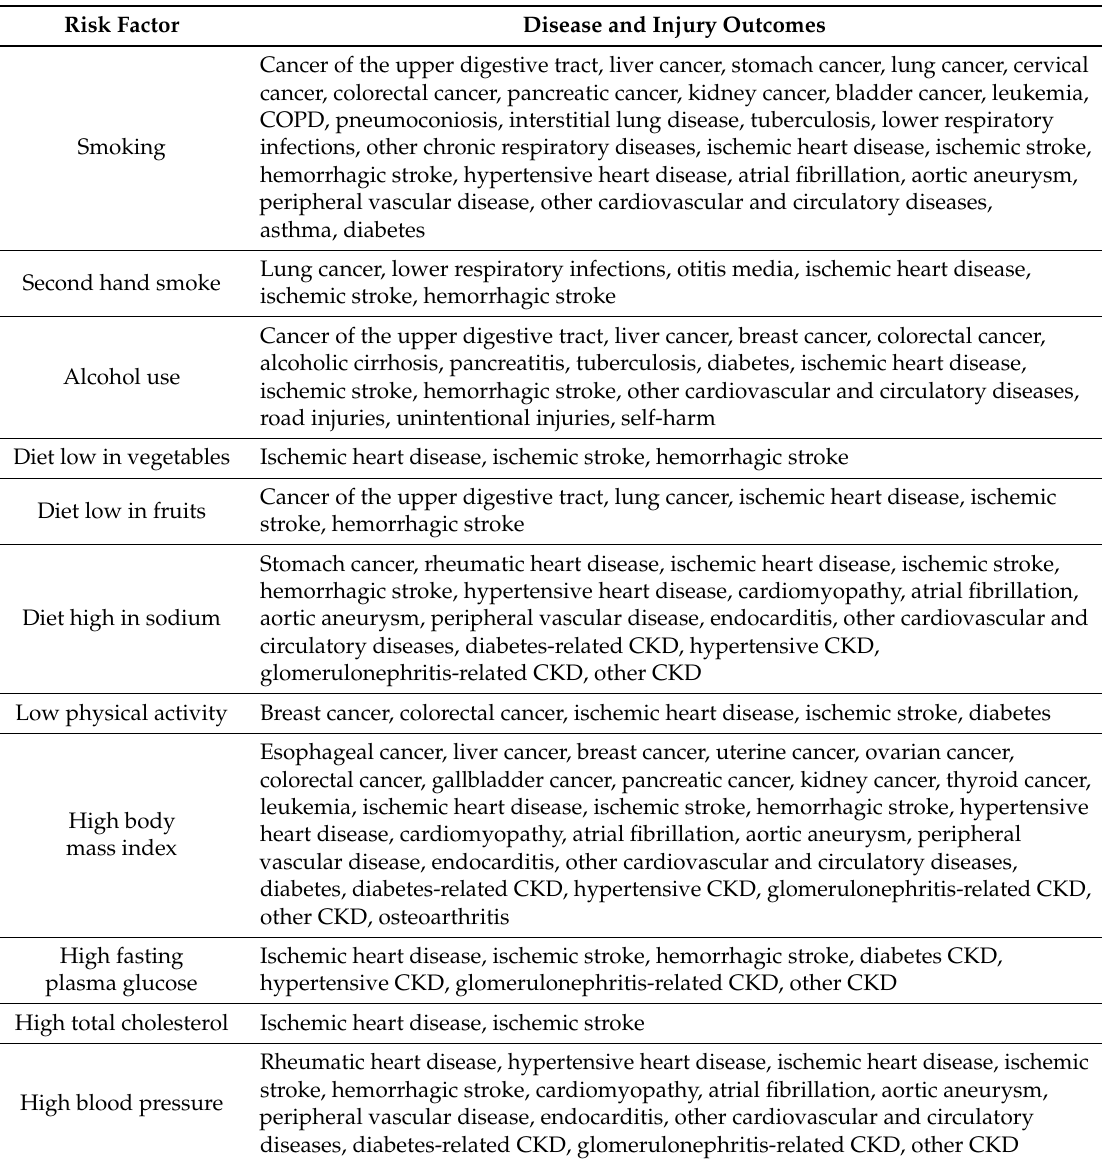
Table 1. Main diseases and injuries related to each risk